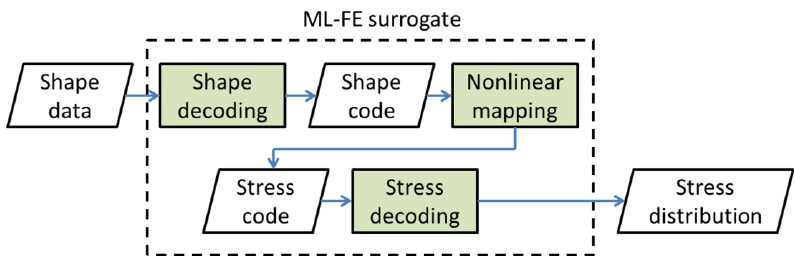
Figure 6: Machine learning (ML)-finite element (FE) surrogate model. Figure 6. Machine learning (ML)-finite element (FE) surrogate